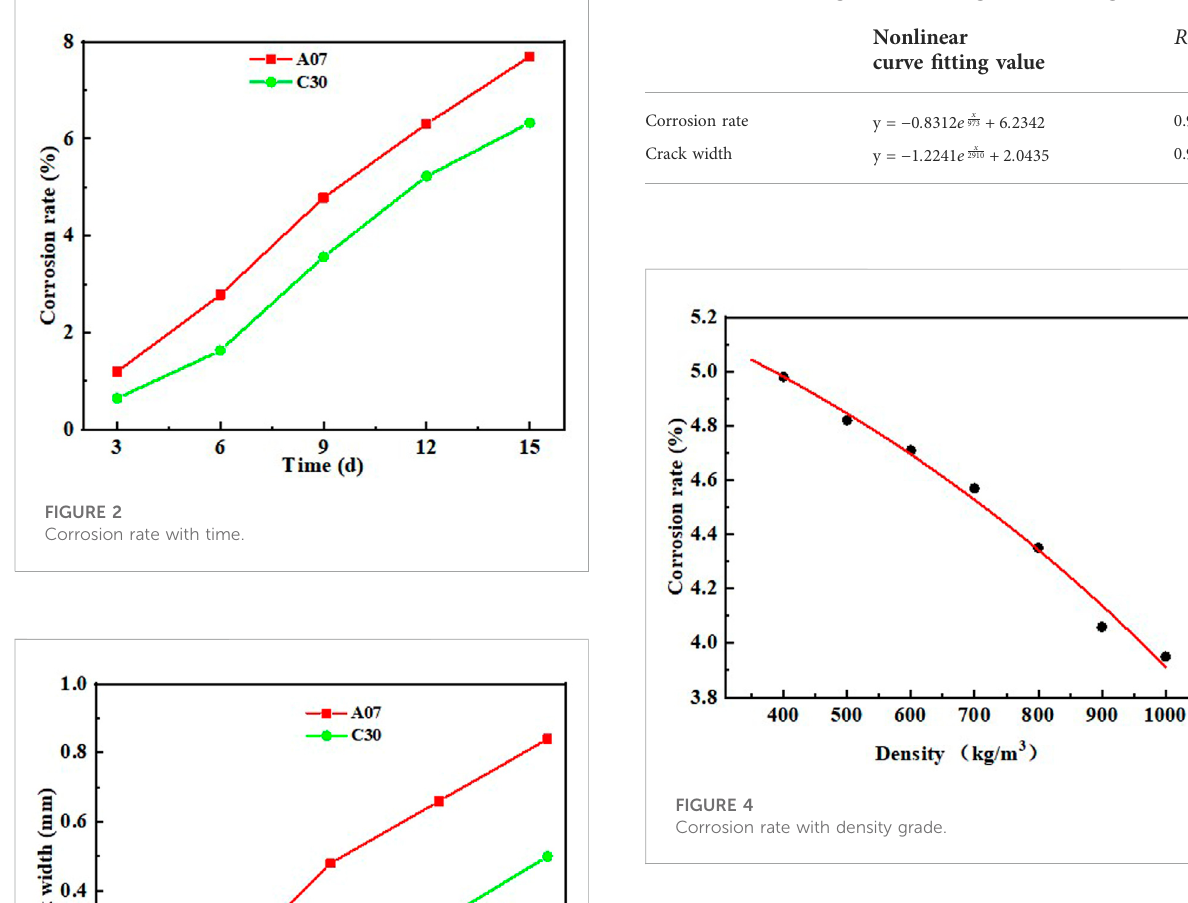
TABLE 3 Function fi tting value and fi tting correlation degree.